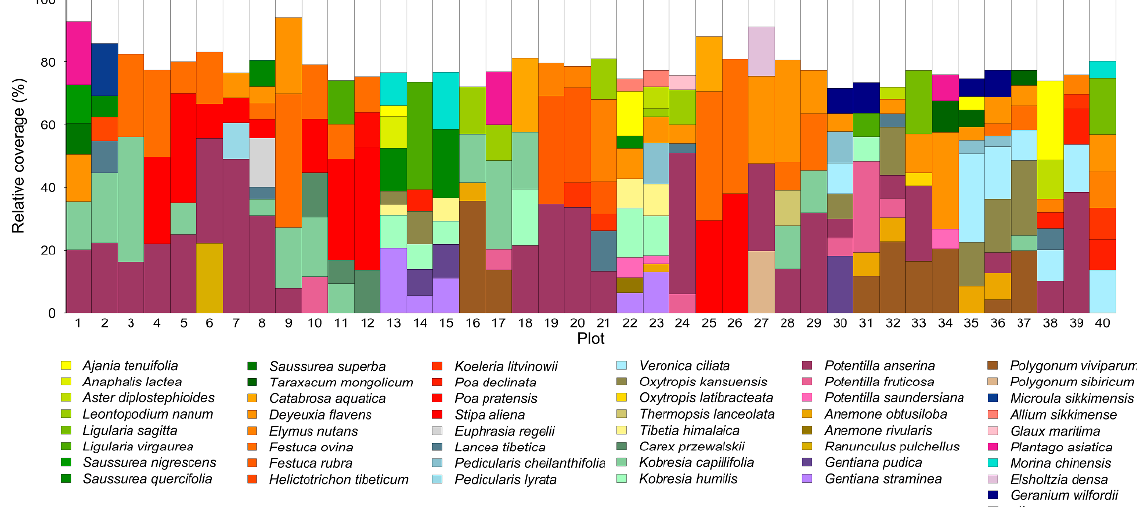
Figure 2. The sampled species composition and relative coverage in the 1 m × 1 m area (correspond- ing to the purple boxes in Figure 1D) in each plot used in this study.